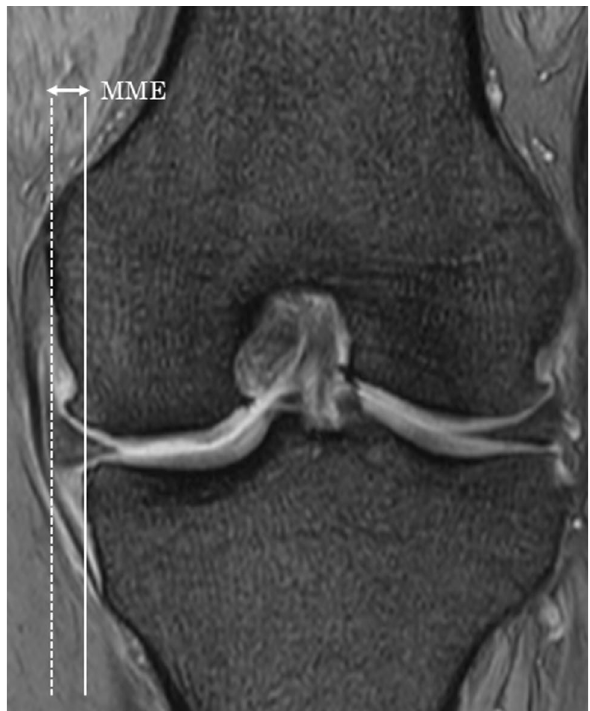
Figure 3. Methods for evaluating MME via coronal plane MRI. MME medial meniscal extrusion, MRI magnetic resonance